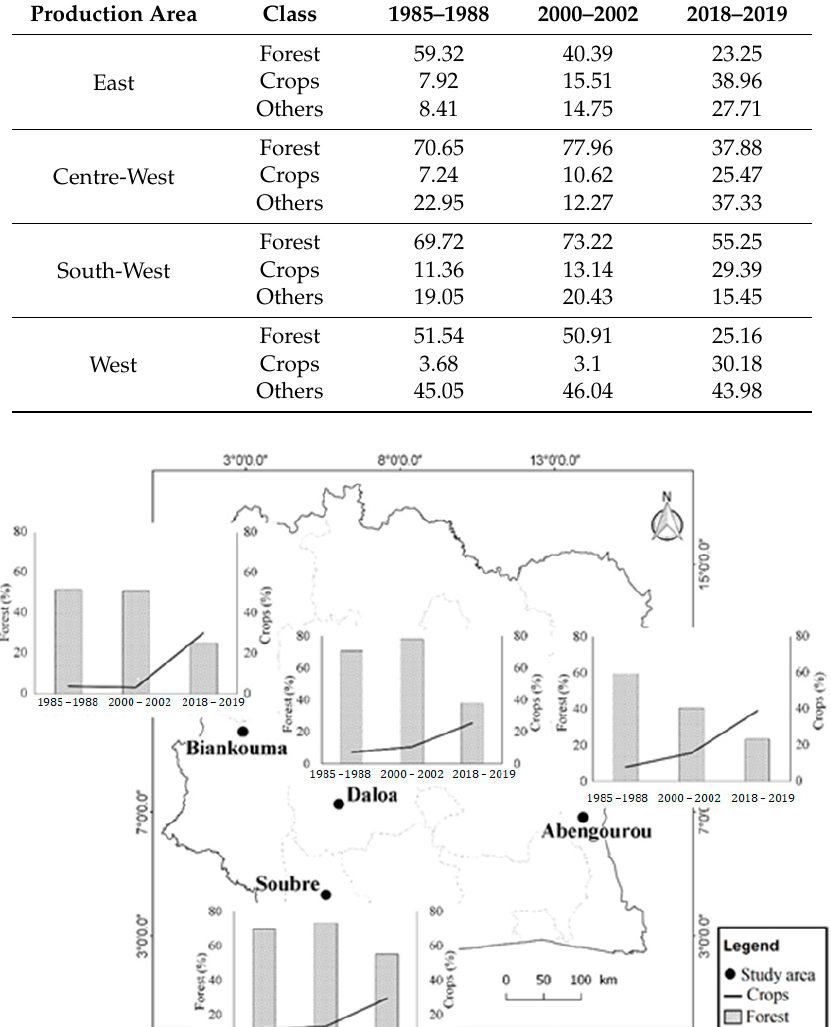
Table 3. Proportion (%) of land-cover occupation.